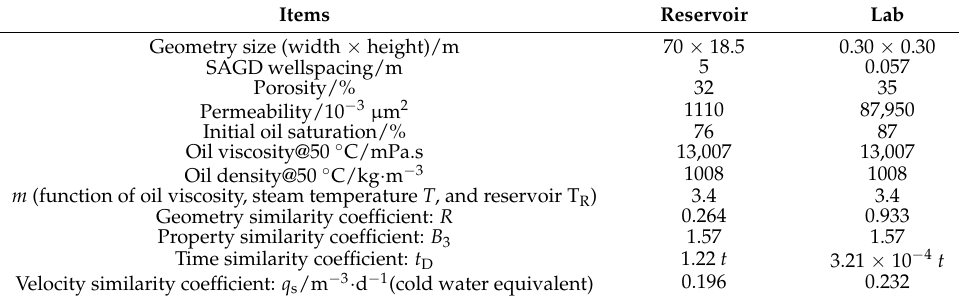
Table 1. Design results of the reservoir and 3-D physical model.